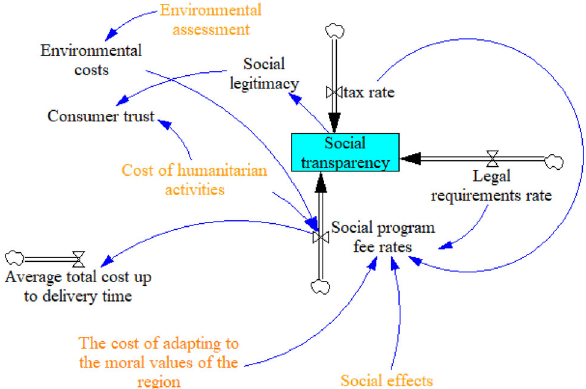
Fig. 2 The stock-flow diagram for social transparency